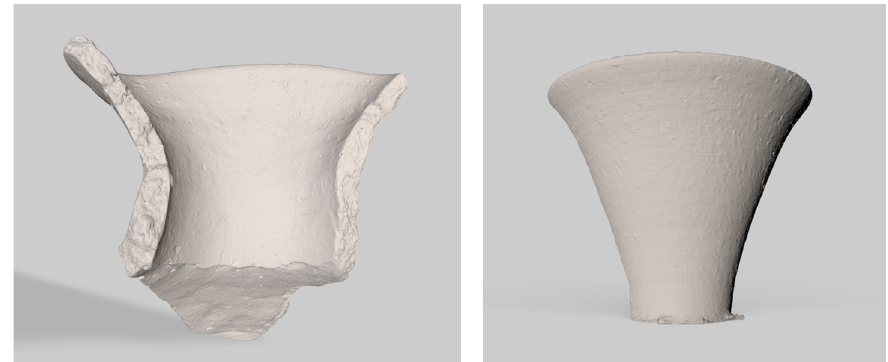
Figure 6: Comparison of models of ( left ) the author and ( right ) the apprentice. Image by